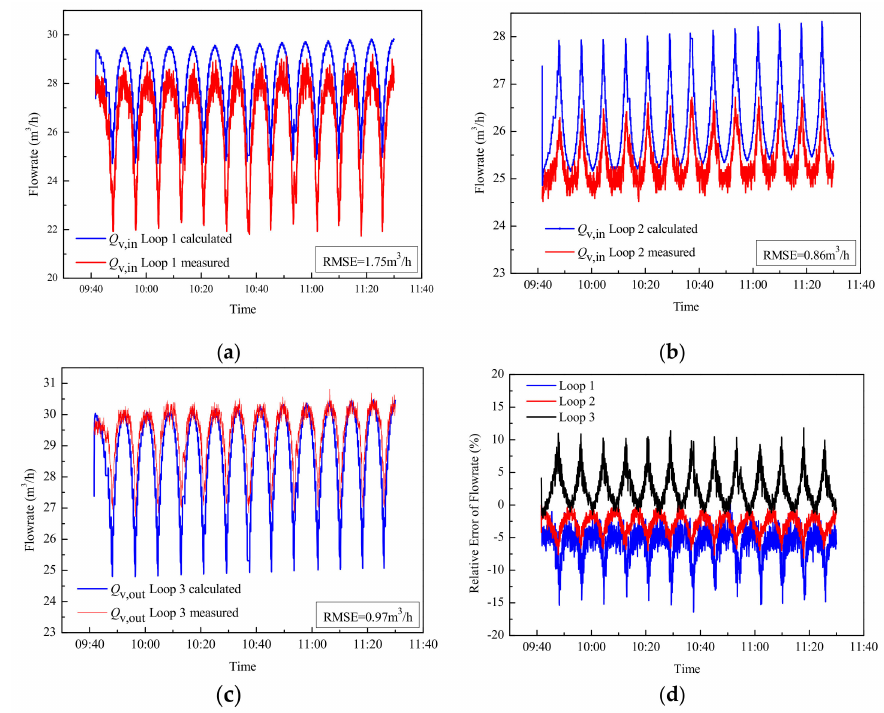
Figure 10. Compared results between calculated and measured data in cold test for ( a – c ): the outlet flow rate of loops 1 to 3; and ( d ) the relative errors of flow